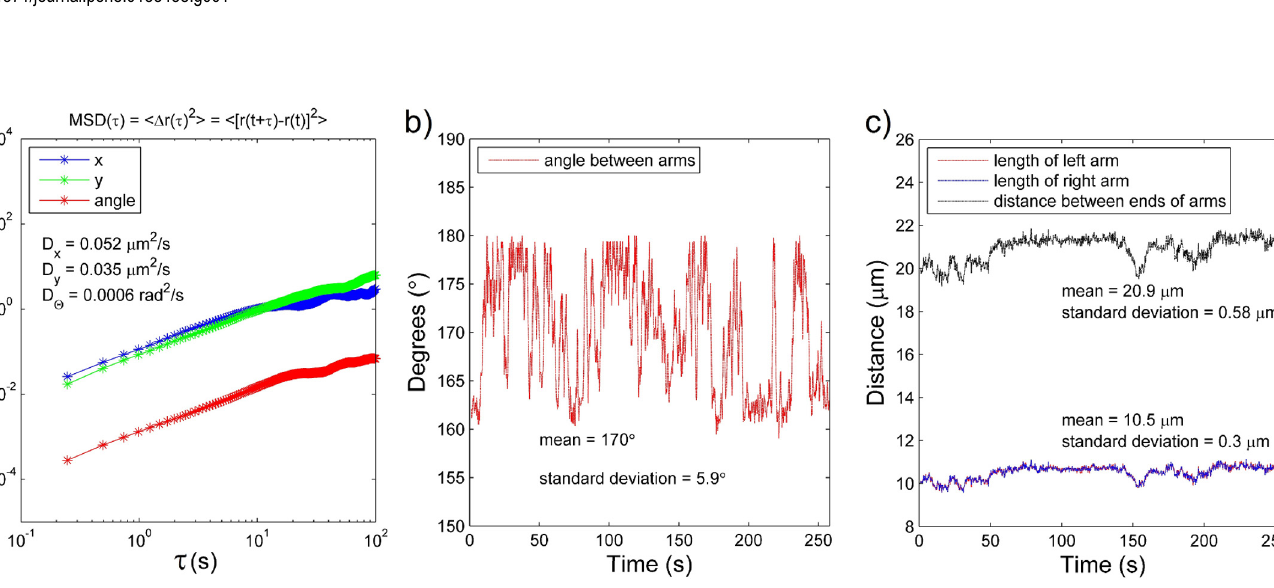
PLOS ONE | DOI:10.1371/journal.pone.0133458 July 20,